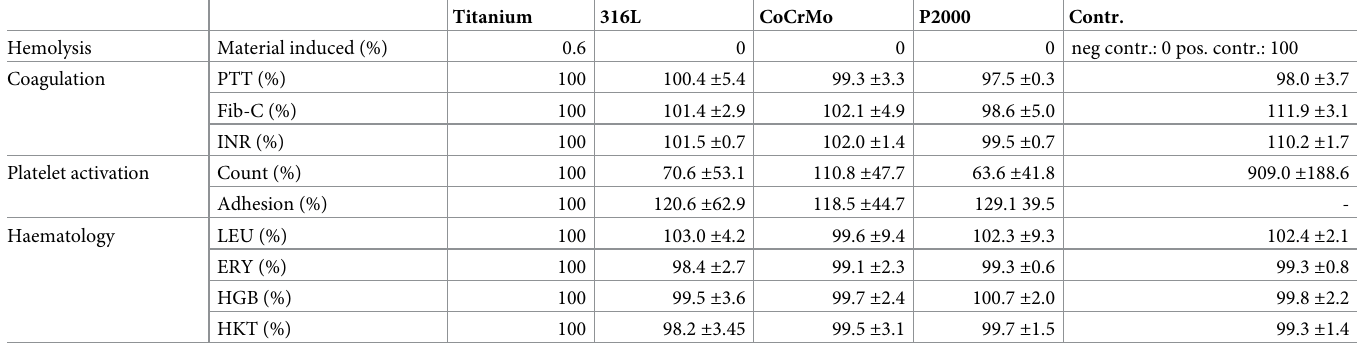
Table 1. Categories and results of blood interaction tests. Titanium 316L CoCrMo P2000